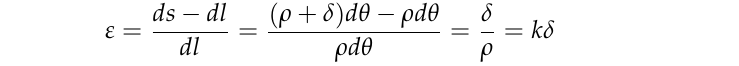
Figure 2. Side view of the bending fi ber optic sensor.